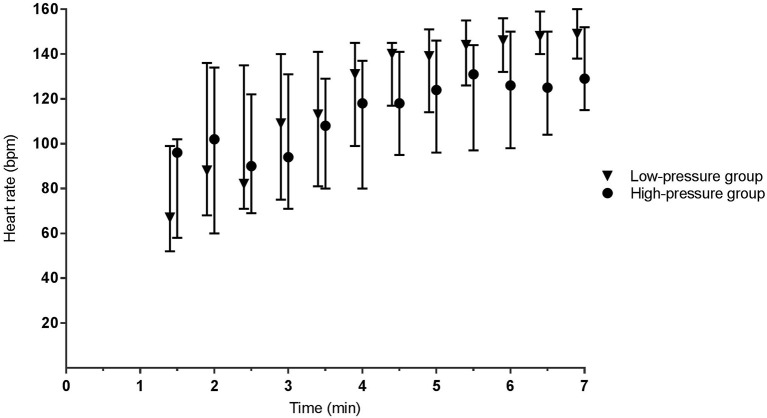
Heart rate. Data is presented as median (IQR). At 1.5 and 2 min, the mean of the high-pressure group is calculated based on n = 9 and n = 16, respectively. All other presented data is based on n ≥ 20.